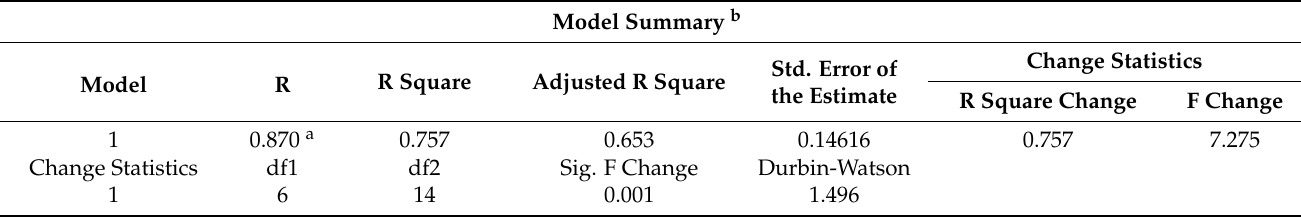
Table 5. The model of analysis for Ireland.